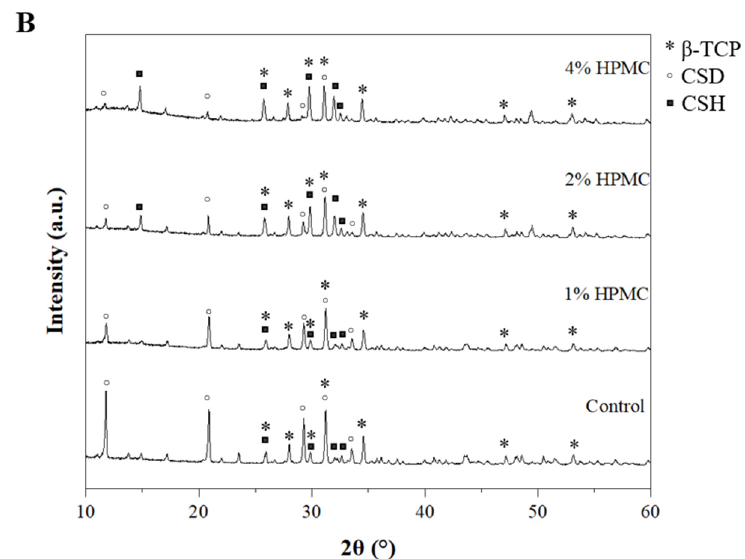
Figure 4. X-ray diffractometry patterns of premixed putty containing HPMC with different mass ratios after being soaked for 4 h (*: β -TCP; ◦ : calcium sulfate dihydrate (CSD), ▪ : CSH). ( A ) Patterns of the main body. ( B ) Patterns of particles.